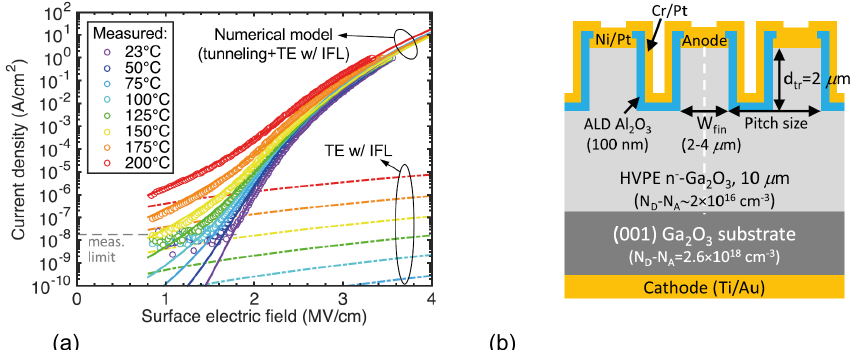
Figure 3. ( a ) Comparison of physical models for the calibration of reverse leakage current. Reprinted from [79], with the permission of AIP Publishing. ( b ) Device diagram of the trench β-Ga 2 O 3 SBD. Reprinted from [81], with the permission of AIP Publishing.